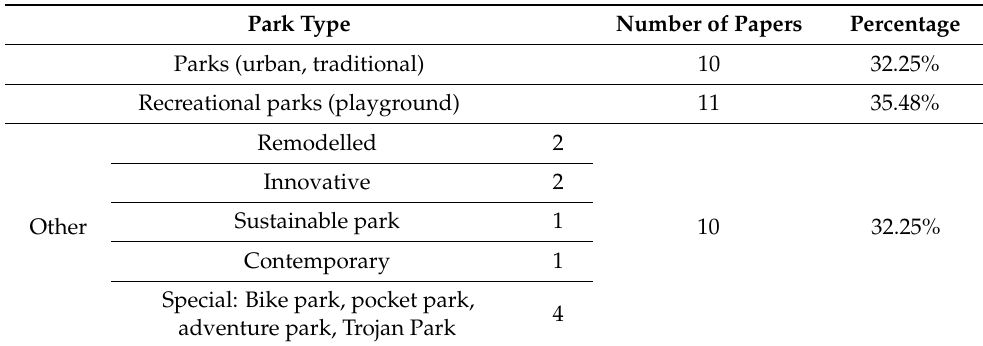
Table 3. Types of parks